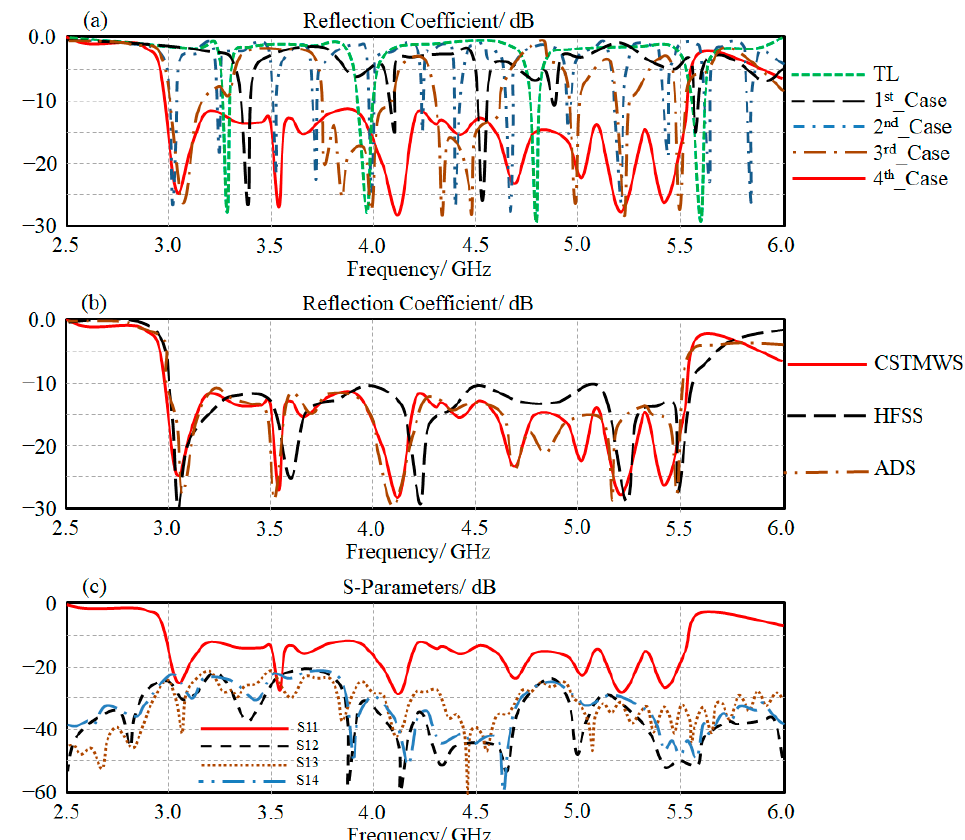
Figure 7. S-parameters spectra evaluation: ( a ) reflection coefficient (dB) of the considered cases, ( b ) validated reflection coefficient (dB) results, and ( c ) S-parameters (dB): S 11 , S 12 , S 13 , S 14 .